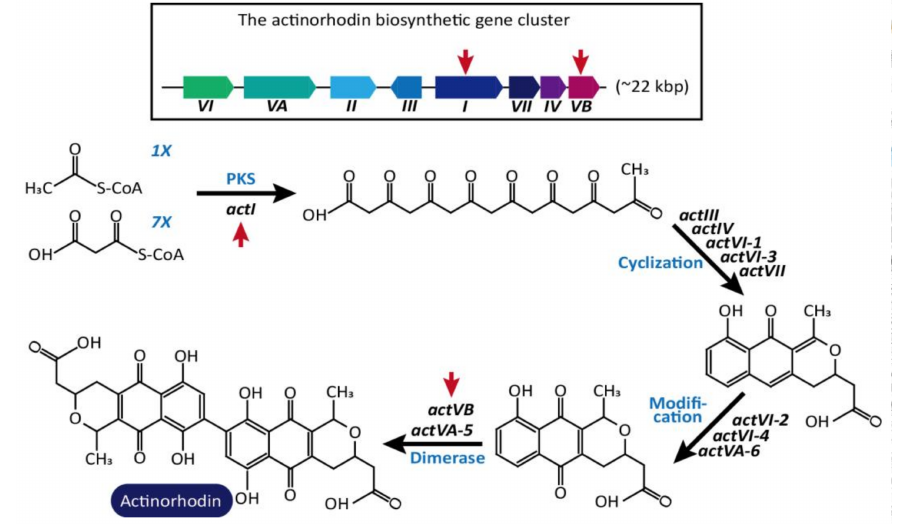
Figure 3. Regulation of actinorhodin biosynthetic pathway in S. coelicolor A3. The organization of